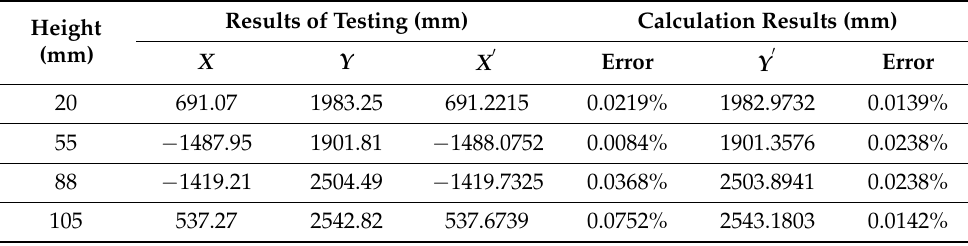
Table 7. Verification of the applicability of the rigid transformation